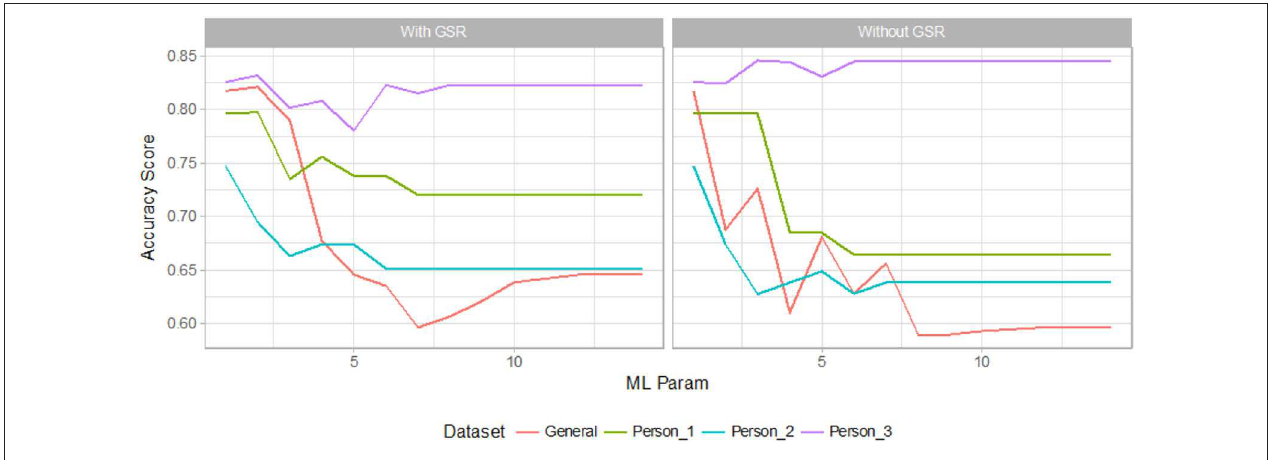
FIGURE 5 | Decision tree performance.